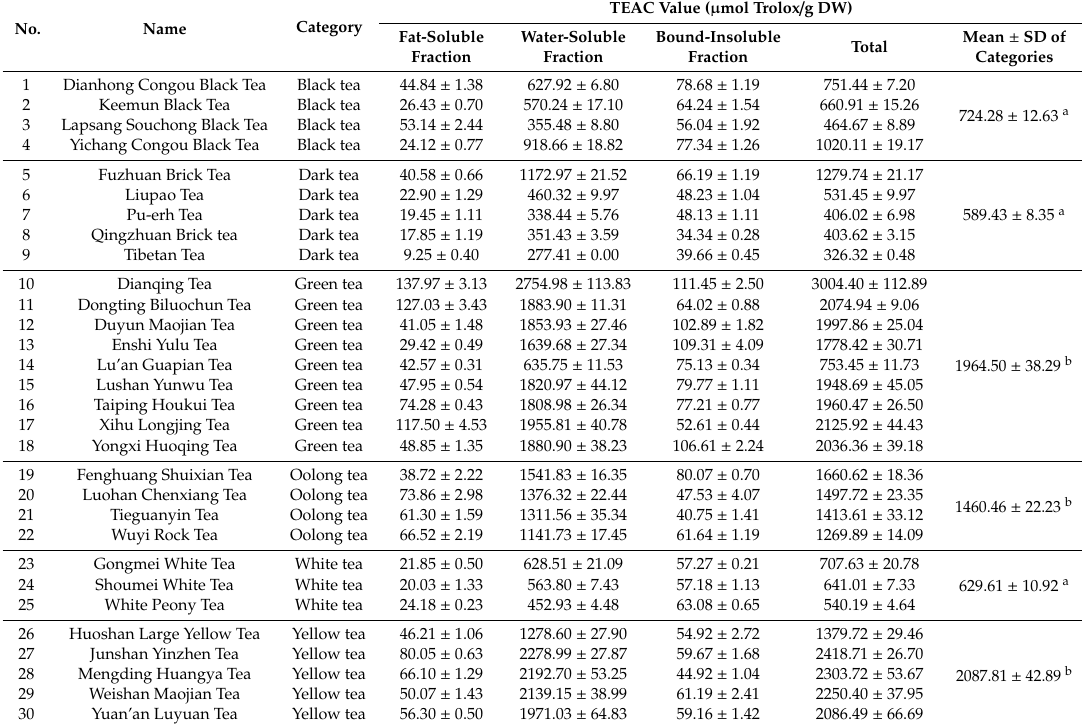
and non-parametric tests (Table 3), TEAC values for the three fractions met the following order: water-soluble > bound-insoluble > fat-soluble bound. Table 4. Trolox equivalent antioxidant capacity (TEAC) values of the 30 common Chinese teas.